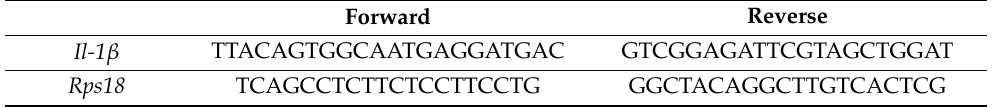
Table 1. Primers used for real-time